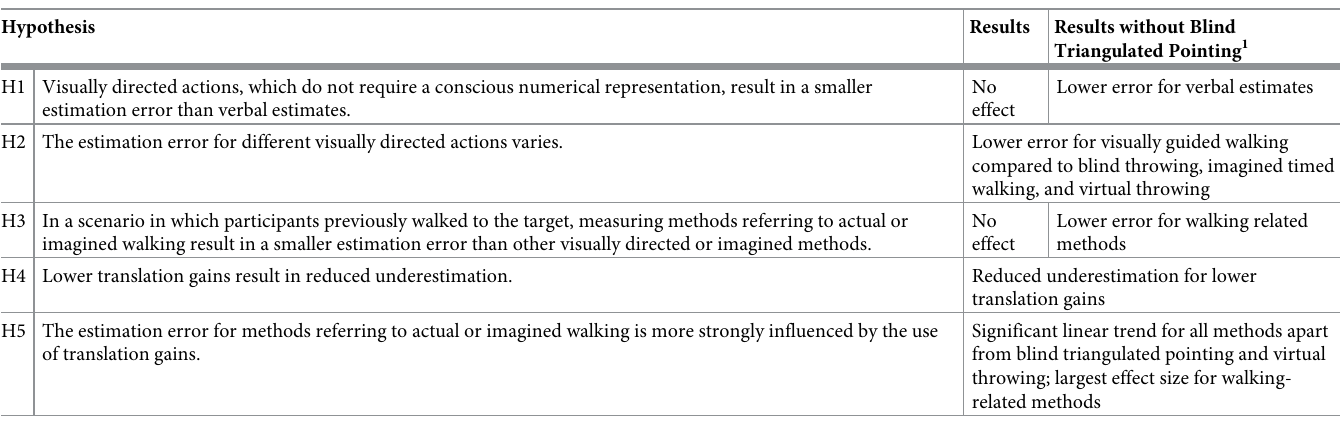
Table 1. Results overview.